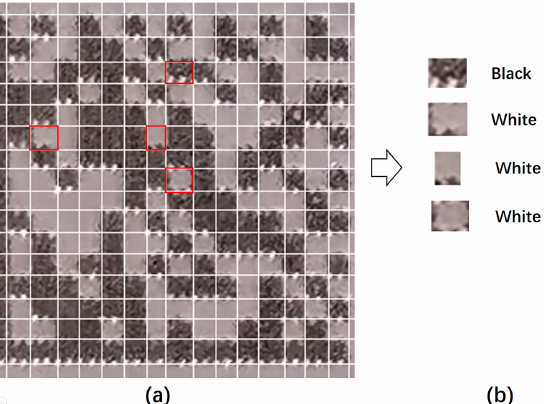
Figure 4. Traditional sampling: ( a ) sample by a single module; ( b ) sample examples and color